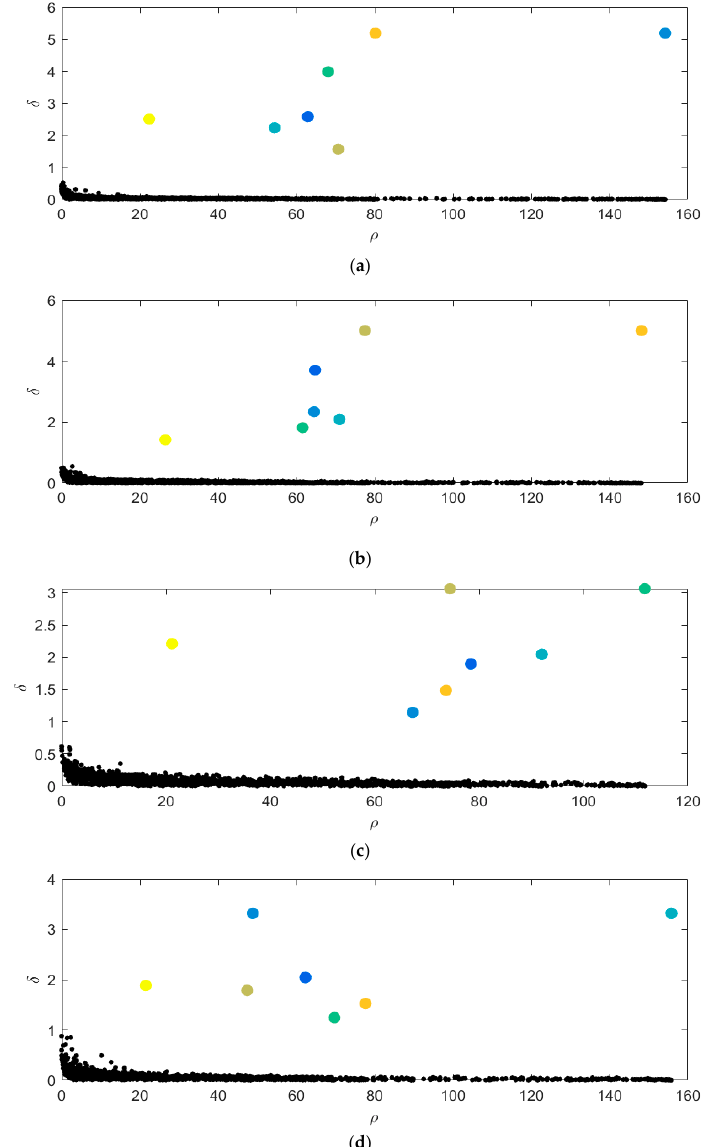
Figure 10. Density, distance decision graph of 4 universities: ( a ) S1; ( b ) S2; ( c ) S3; and ( d ) S4. γ value is shown as Figure 11. According to the γ value, the γ values of the seven scattered points were relatively large, so the four kinds of data were divided into seven cluster centers. The cluster centers are shown as Table 4, and the clustering results are shown in the Figure 12.